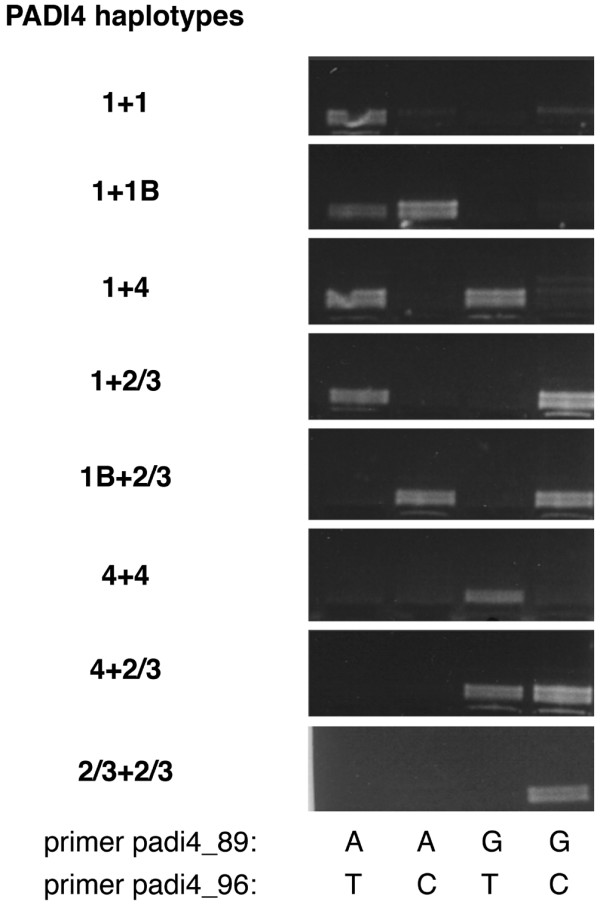
Determination of PADI4 haplotype constellations by haplotype-specific long-range PCR. Eight genomic DNA samples with different PADI4 haplotype constellations were tested by haplotype-specific long-range PCR using primer mixes specific for padi4_89*A/padi4_96*T (haplotype 1), padi4_89*A/padi4_96*C (haplotype 1B), padi4_89*G/padi4_96*T (haplotype 4), and padi4_89*G/padi4_96*C (haplotype 2/3).